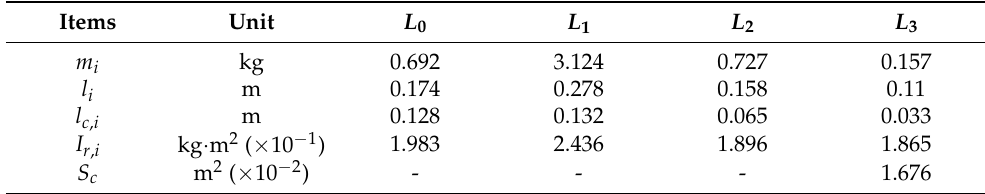
Table 2. Configuration parameters of the robotic dolphin.